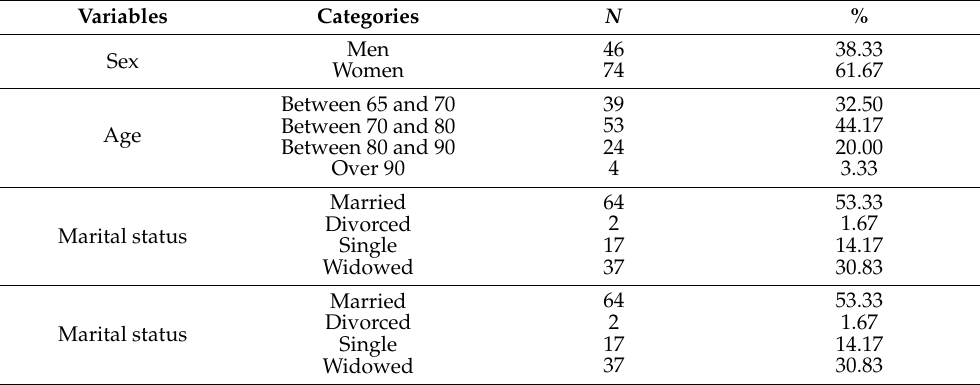
Table 1. Characteristics of the sample ( N =